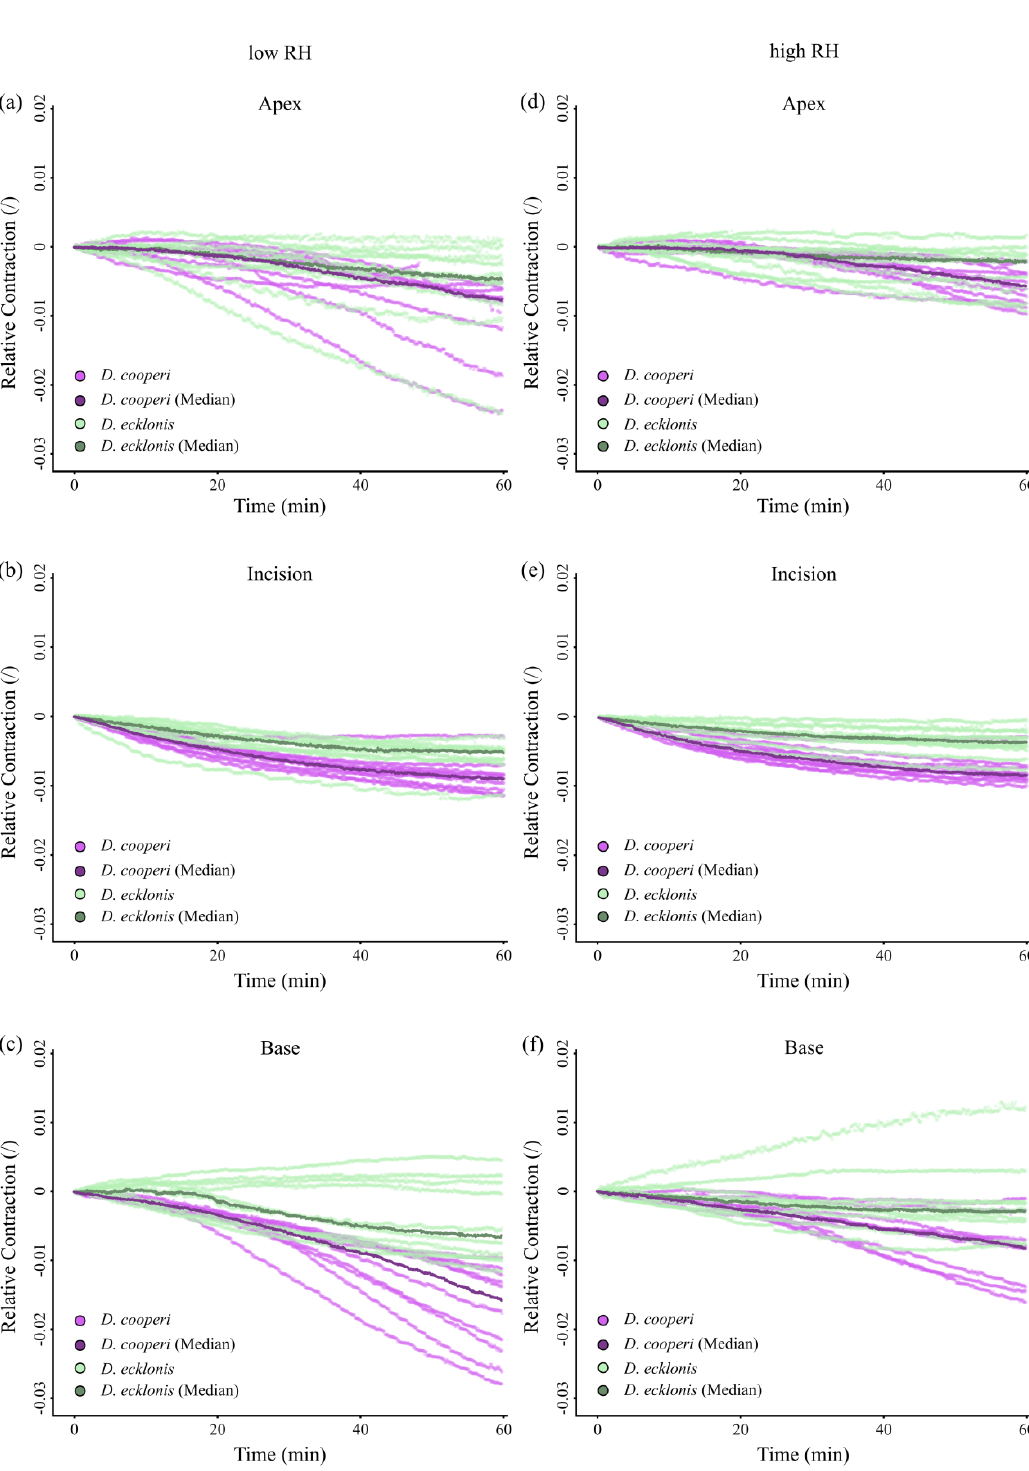
Figure 7. Relative values of self-sealing kinematics of D. cooperi and D. ecklonis at two different humidity levels (RH). ( a – c ) Relative contractions of leaf segments (apex, incision region and base) at low RH ( D. cooperi : 44.0%; D. ecklonis : 43.6%) over time. ( d – f ) Relative contractions of leaf segments (apex, incision region and base) at high RH ( D. cooperi : 59.6%; D. ecklonis : 57.3%) over time. Each graph depicts the ten individual measurements (light colors) and their corresponding median lines (dark colors) for both D. cooperi (purple curves) and D. ecklonis (green curves).